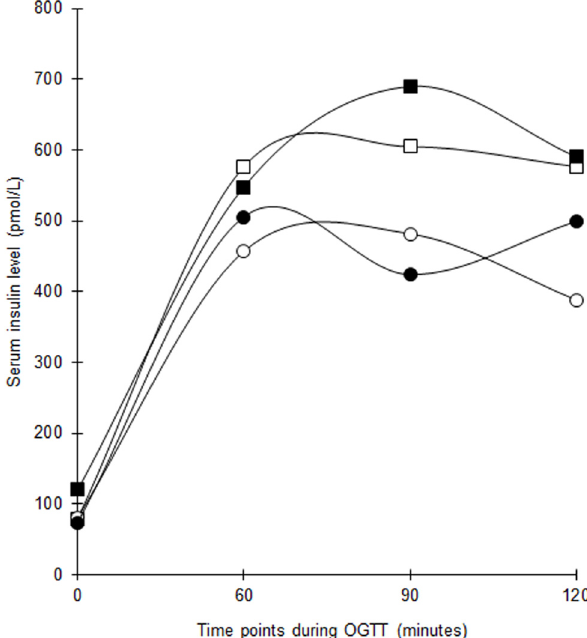
Fig 4. Changes in median serum insulin levels throughout 2-hour OGTT at baseline and post intervention among women with former GDM in both groups. White squares = Vitamin D group (baseline). Black squares = Vitamin D group (post intervention). White circles = Placebo group (baseline). Black circles = Placebo group (post intervention).The baseline differences of median serum insulin levels between vitamin D-supplemented group and placebo group at 0 (p = 0.878), 60 (p = 0.457), 90 (p = 0.489) and 120 (p = 0.112) minutes were not statistically